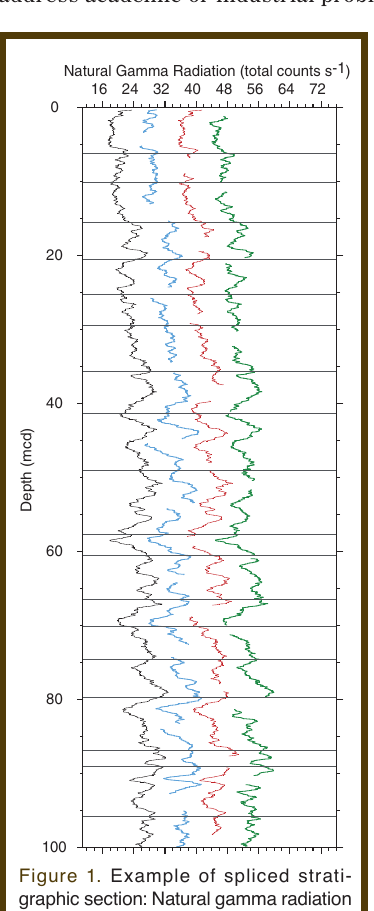
Figure 1. Example of spliced strati- graphic section: Natural gamma radiation data from ODP Site 1146 (black) was compiled by splicing the individual core logs (blue, red, green, Wang et al.,